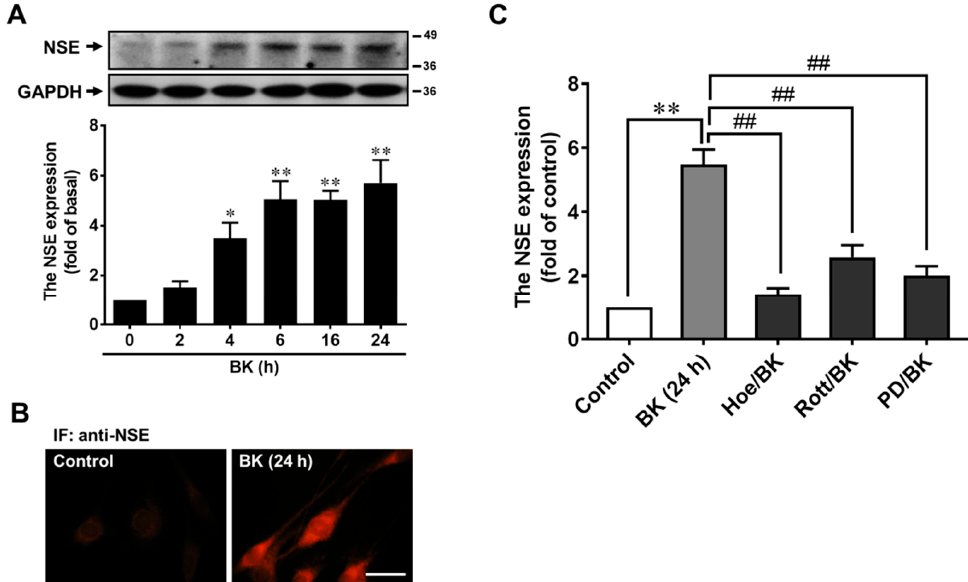
Figure 6. BK upregulates the neuronal marker NSE expression in RBA cells. ( A ) Time dependence of BK-induced upregulation of NSE protein expression. Cells were treated with 10 nM BK for the indicated times. ( B ) The upregulation of NSE by BK was confirmed by immunofluorescence in RBA cells. Cells were incubated without (control) or with BK (10 nM) for 24 h and then labeled using an anti-NSE antibody and a FITC-conjugated secondary antibody. Individual cells were imaged (scale bar = 20 µ m) as described in “Methods”. ( C ) Cells were pretreated with Hoe140 (Hoe, 10 µ M), rottlerin (Rott, 1 µ M), PD98059 (PD, 10 µ M) for 1 h and then incubated with BK (10 nM) for 24 h. The whole-cell lysates were analyzed by Western blot using an anti-NSE or anti-GAPDH antibody as described under “Methods”. Data are expressed as the mean ± SEM of at least three independent experiments. * p < 0.05, ** p < 0.01, as compared with control. ## p < 0.01, as compared with BK alone. The image represents one of at least three individual experiments.